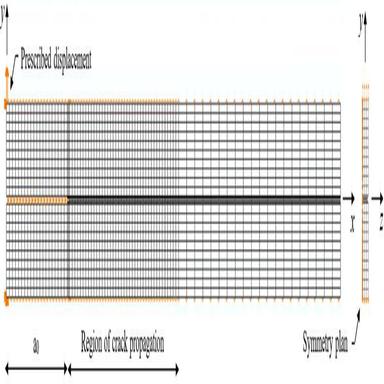
Mesh and boundary conditions used in the numerical analysis.